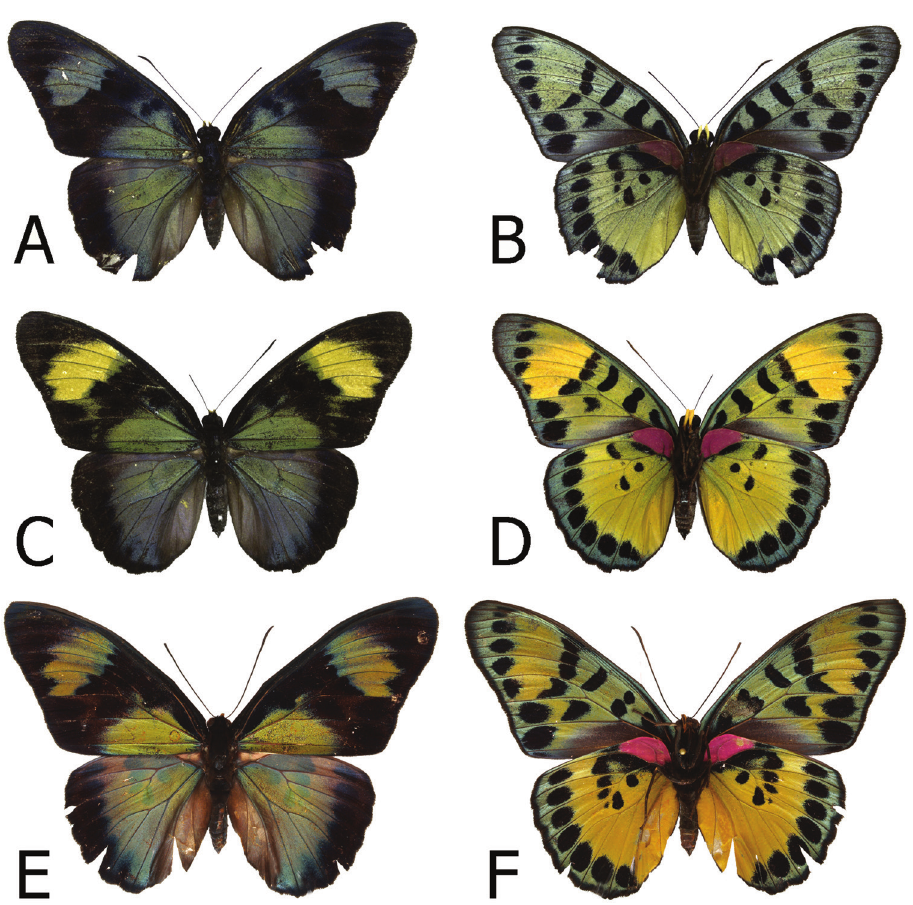
Figure 4. Adults, females: A E. cyparissa tai Tai, Ivory Coast (venter) B E. cyparissa tai Tai, Ivory Coast (venter) C E. cyparissa aurata Isheri, Nigeria (dorsum) D E. cyparissa aurata Isheri, Nigeria (venter) e E. cyparissa nominalina Borgen Dolphin Platform, paratype (dorsum) F E. cyparissa nominalina Borgen Dolphin Platform, paratype